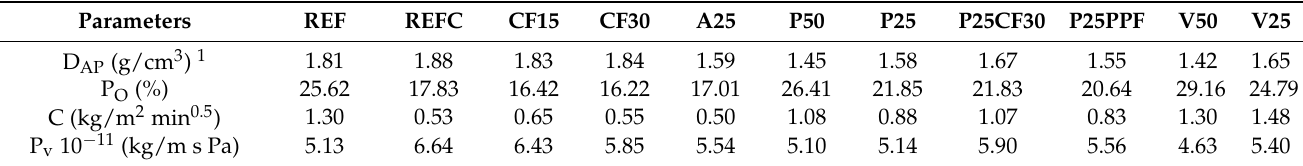
Table 2. Physical properties related to mortar microstructure (adapted from [6,30]).